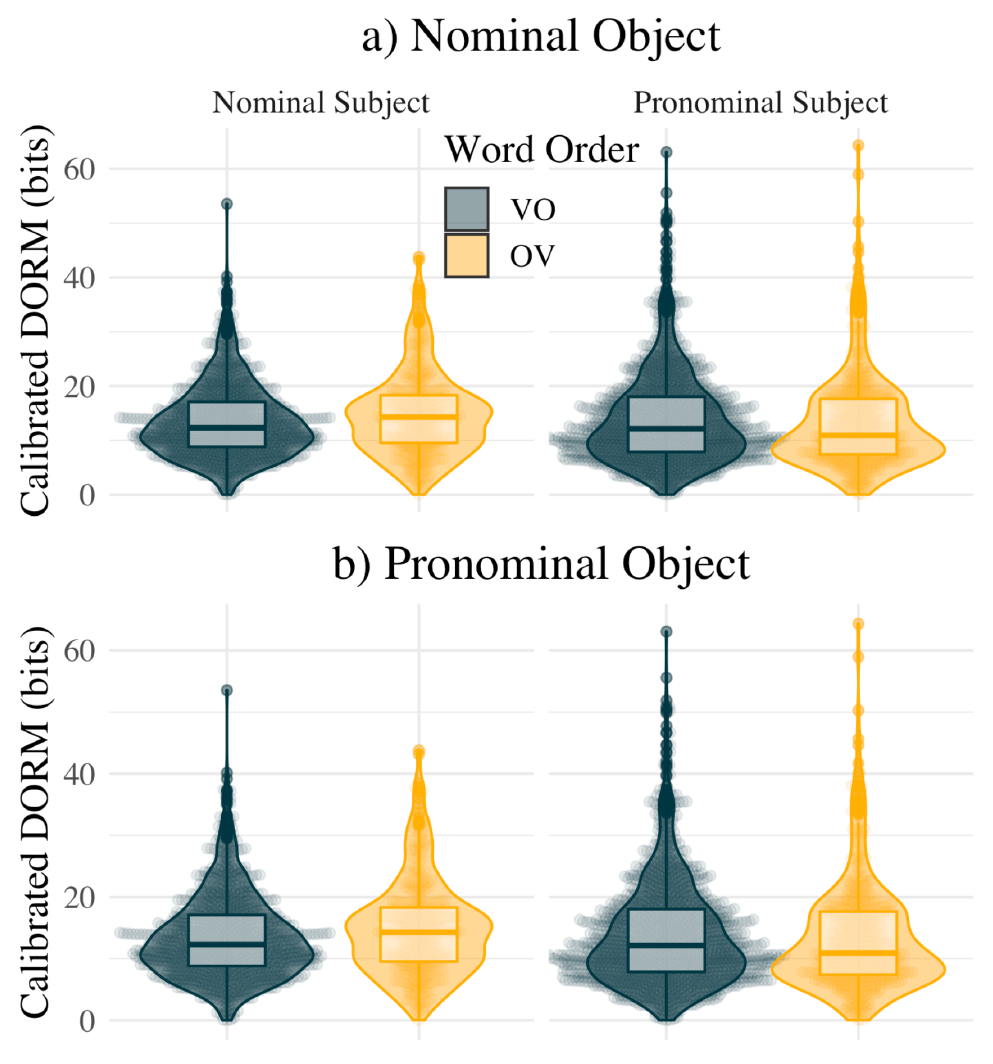
Figure 3. Calibrated DORM values for Icelandic sentences by Subject type, Object type and v P/VP word order. Note that where the Subject and Object types are matched in ( a ), VO results in greater uniformity (lower DORM), and elsewhere OV results in greater uniformity. In ( b ), the effect is less certain, and may be carried by the tails of the